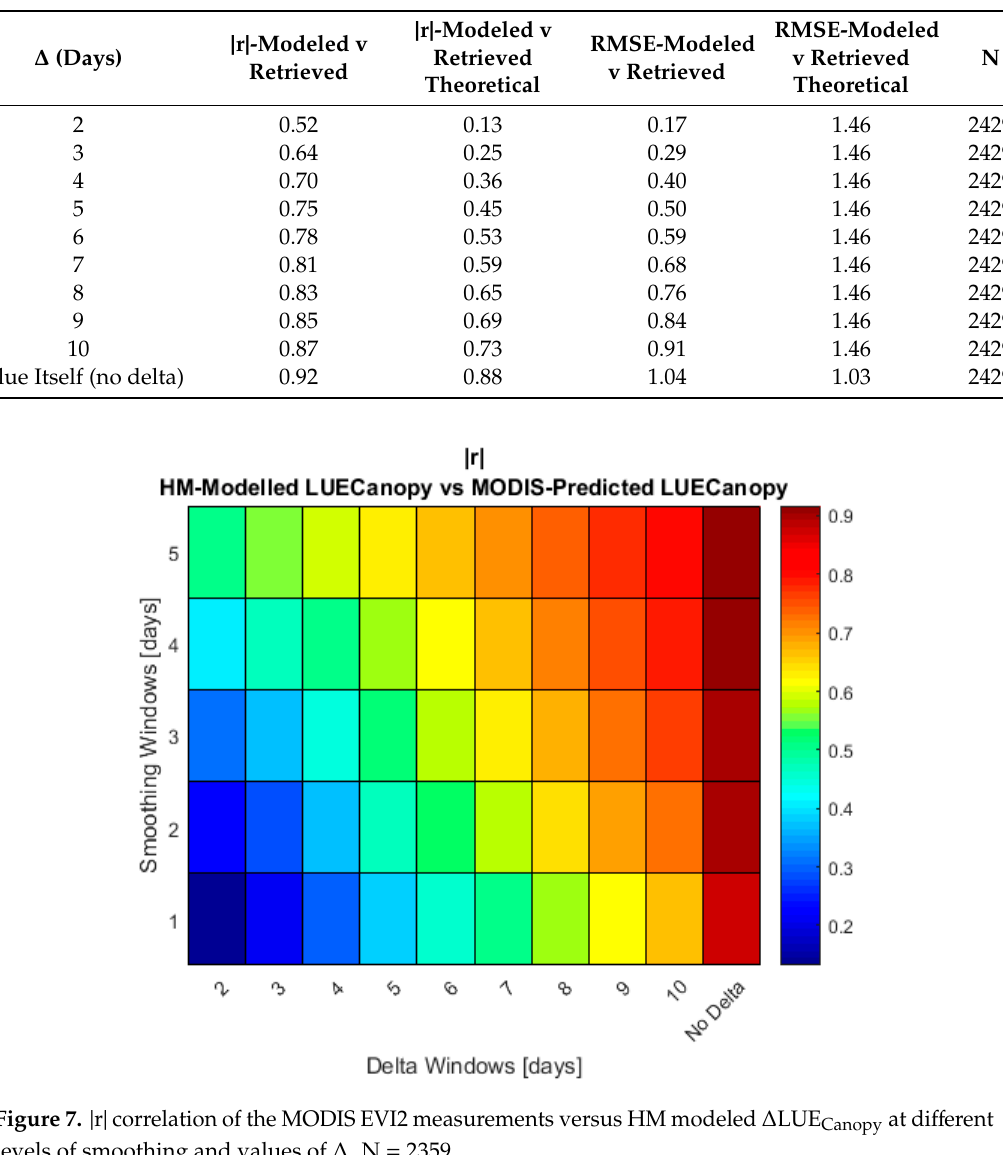
Table 5. Comparison of HM modeled versus retrieved, actual and theoretical | r | and RMSE for the retrieval of ∆ LAI and LAI at di ff erent values of ∆ .